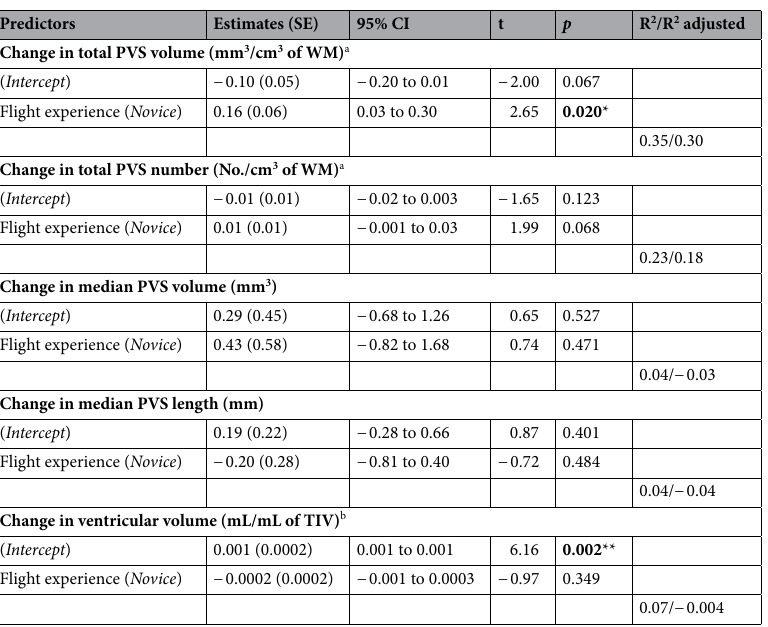
Table 3. PVS changes and ventricular expansion from pre- to post-flight: novice vs. experienced differences. * p < 0.05, ** p < 0.01; significant p values are bolded. SE standard error, CI confidence interval, WM white matter, TIV total intracranial volume. Here we report the results of linear models testing whether the pre- to post-flight change in each PVS metric and ventricular volume differed for the novice vs. experienced astronauts. Experienced astronauts served as the reference group. Our primary interest here was whether there was an effect of previous flight exposure on pre- to post-flight change in the PVS and ventricle metrics. Note that the novice vs. experienced predictor was the only variable that the stepwise regression included in the final statistical model for total PVS volume. Age, sex, time elapsed between landing and first MRI scan, and flight duration were not included in the final model produced by the stepwise approach. See Table S1 for whole-group and subgroup descriptive statistics at each time point. See Table S2 for the results of the model testing for pre- to post-flight changes in PVS metrics and ventricular volume for the entire ( n = 15) astronaut cohort. a To account for individual differences in total brain tissue volumes, total PVS volume and number were normalized as follows: (total PVS volume (mm 3 ) or number (No.))/(total brain white matter volume (cm 3 ), averaged across the two pre-flight time points). b Ventricular volume represents the sum of the lateral and third ventricular volumes. To account for individual differences in head size, ventricular volume was then normalized as follows: (ventricular volume (mL))/(total intracranial volume (mL), averaged across the two pre-flight time